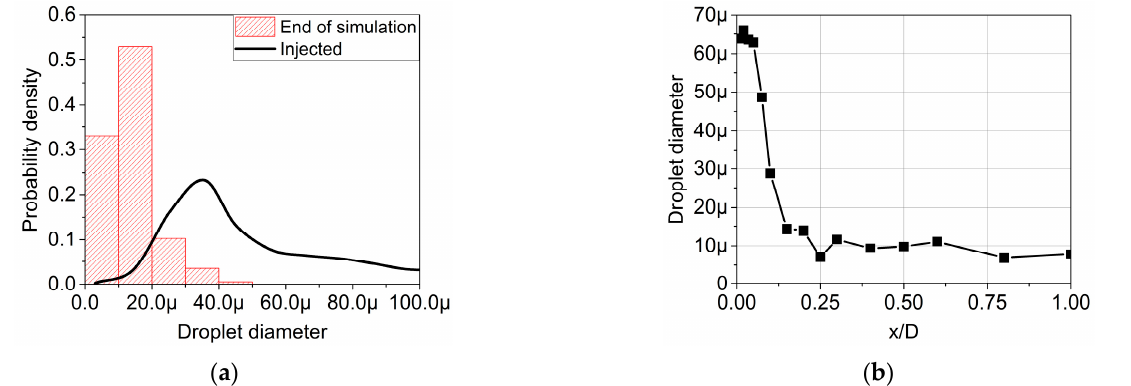
Figure 9. ( a ) Droplet size distribution at the injection and for the end of simulation; ( b ) droplet size along the x-direction. The interaction of water microjets occurs in the shear layer of the gas jet. Droplets are rapidly breakup to a size of about 10 μ m during the distance equal to one jet nozzle diam- eter in the axial direction. The further propagation of water parcels in the shear layer oc- curs their partial evaporation. It is found that about 20% of the mass fraction of water evaporated, while the size of the droplets significantly decreased compared to their initial sizes. 4.3. Acoustic Far-Field Two open surfaces were constructed (they are schematically depicted in Figure 10) using recommendations for FW-H generations from [46,47] for jet-flow acoustic-pressure predictions. Control surfaces began 0.1D downstream of the inflow boundary and ex- tended to 35D along the streamwise direction. Figure 10. A scheme showing the two open control surfaces surrounding the jet (divergence of ve- locity contours are shown).